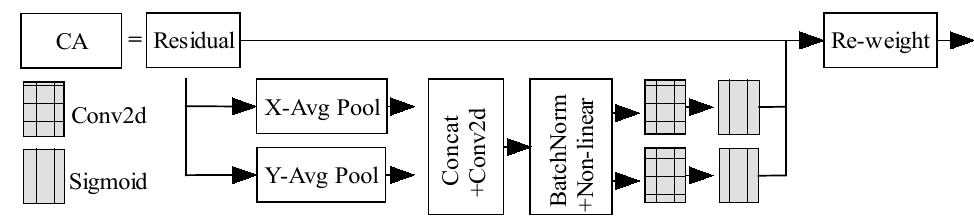
Figure 8. Coordinate attention module.